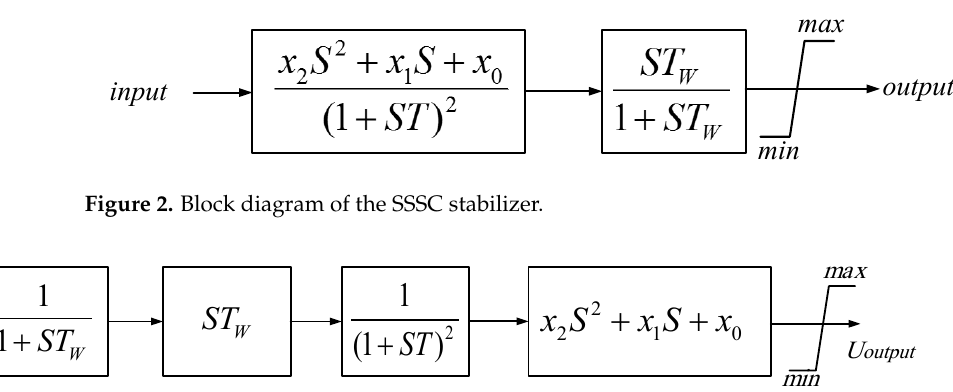
Figure 3. Block diagram of the SSSC stabilizer with new state variables.